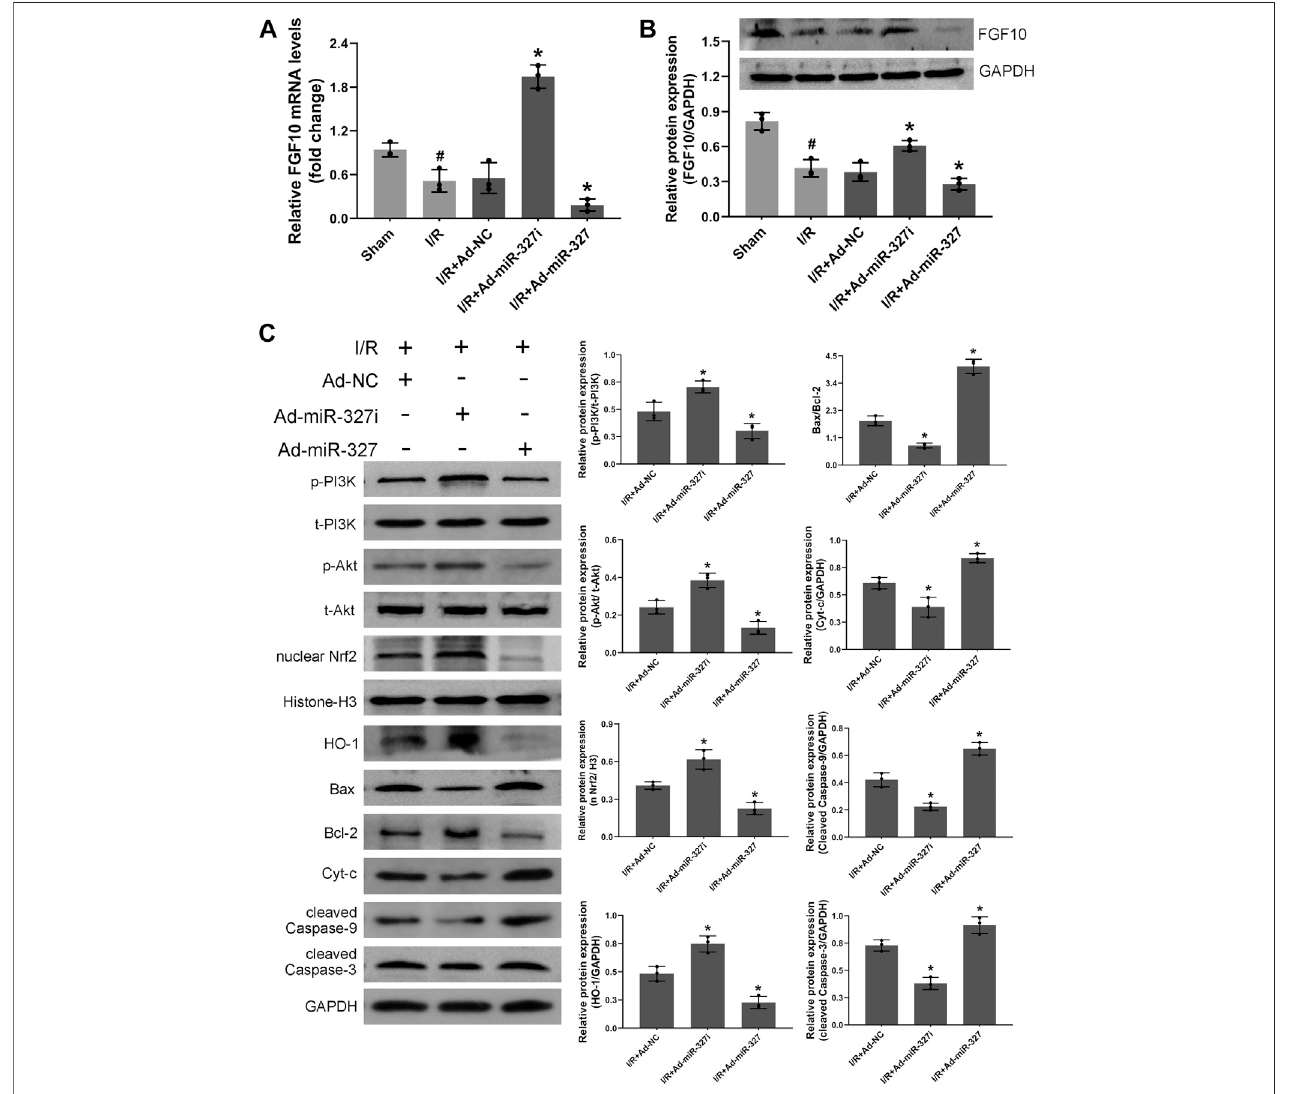
FIGURE 10 | Effects of miR-327 on the FGF10/Akt/Nrf2 signaling pathway in MI/RI rats. FGF10 mRNA and protein levels were measured by qRT-PCR and the Western blot analysis in MI/RI rats heart tissues (A-B) . The proteins of p-PI3K and t- PI3K, t-Akt and p -Akt, nucleus Nrf2, HO-1, Bax, Bcl-2, Cyt-c, cleaved caspase-9, and cleaved caspase-3inhearttissuesweredetectedbytheWestern blotanalysis (C) .Dataareexpressed asthemean ± SD( n (cid:2) 3); # p < 0.05versustheShamgroup; * p < 0.05 versus the Ad-NC group.